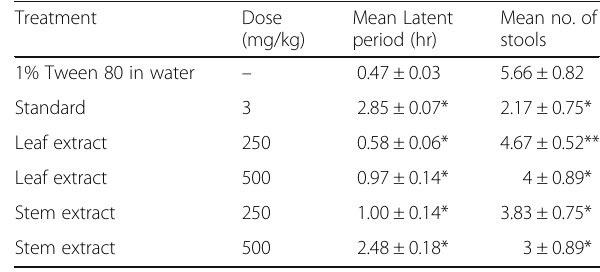
Table 2 Contents of polyphenolic compounds in the ethanol extract of stem Polyphenolic compound